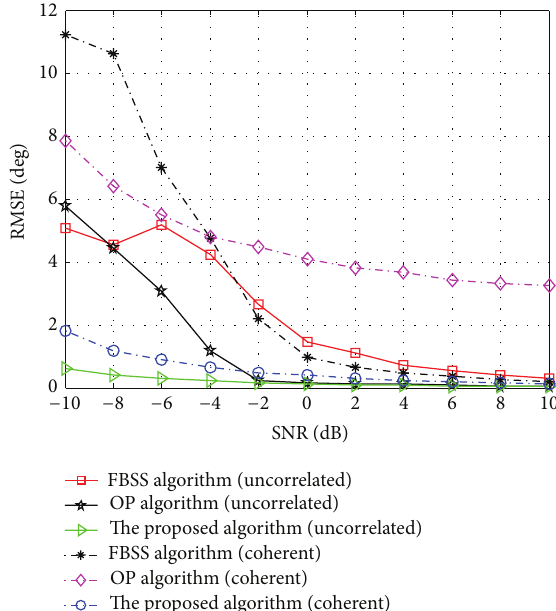
Figure 2: RMSE of the DOA estimates versus input SNR for the uncorrelated and coherent signals.